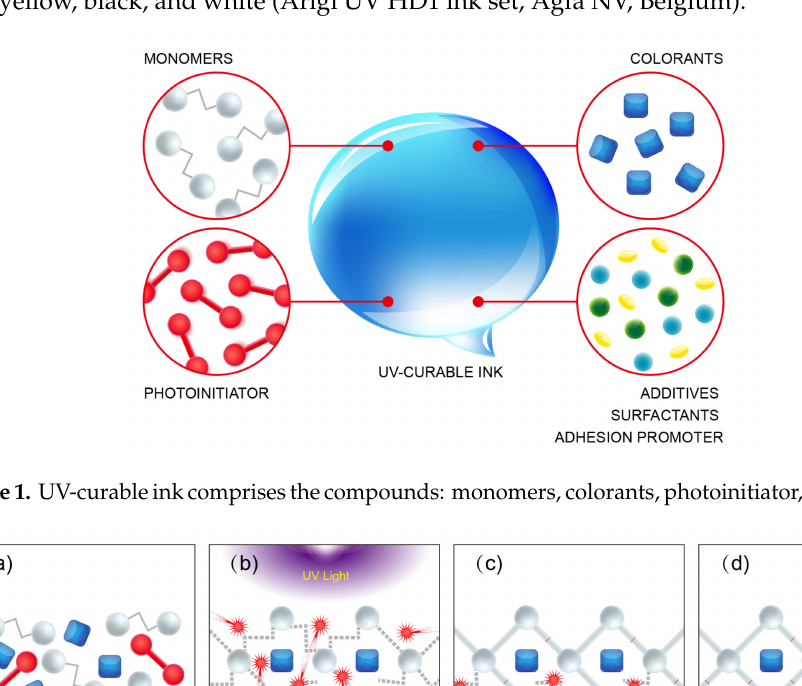
Figure 2. The basic ink set for printing 3D wood texture in the test included five primary colors: cyan, magenta, yellow, black, and white (Arigi UV HD1 ink set, Agfa NV, Belgium).